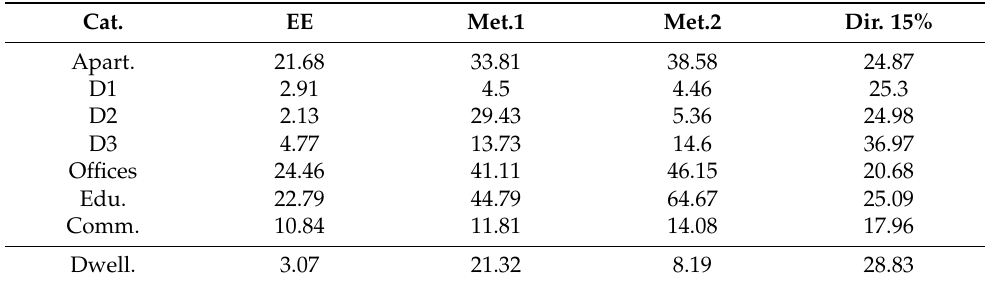
Table 10. Renovation volume (%) to class E, EPBD 2033. Table 10 . Renovation volume (%) to class E, EPBD 2033.